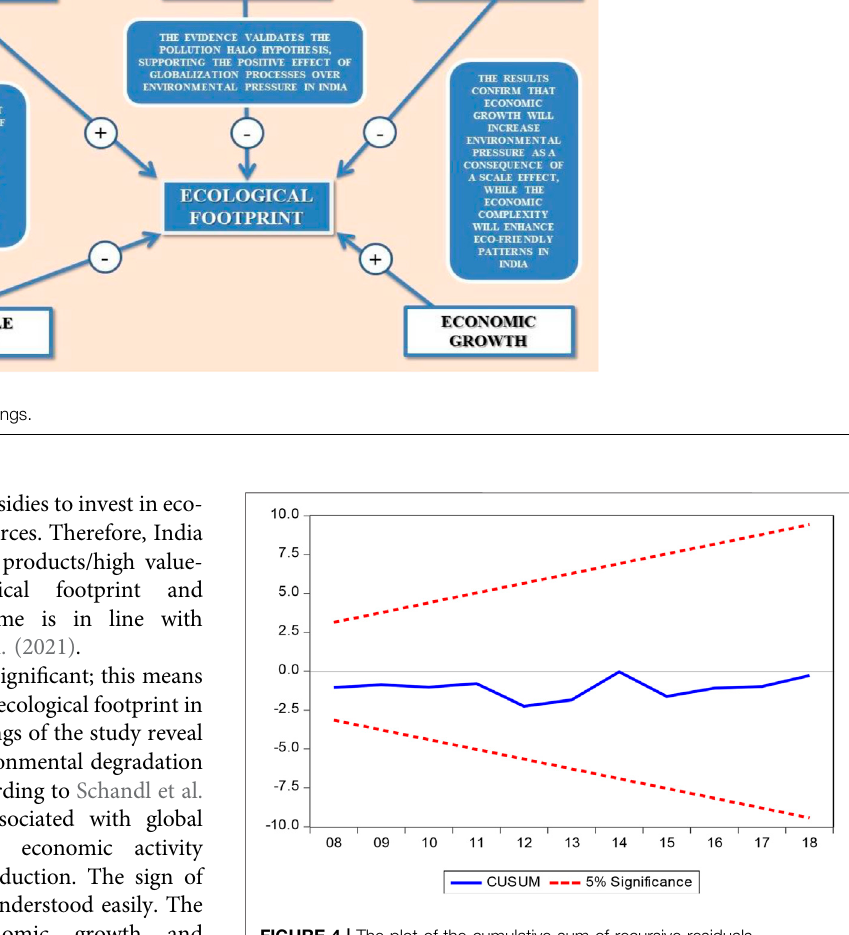
FIGURE 4 | The plot of the cumulative sum of recursive